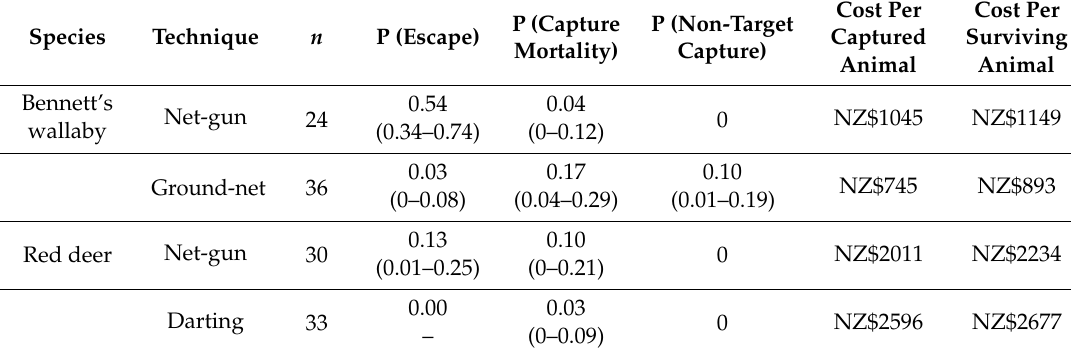
Table 1. Number of animals captured ( n ), proportion (P) of adverse animal welfare events and costs for capture techniques applied to Bennett’s wallaby ( Notamacropus rufogriseus ) and red deer ( Cervus elaphus ) for telemetry studies in South Island, New Zealand, 2018–2019. Numbers in parentheses represent 95% confidence intervals for